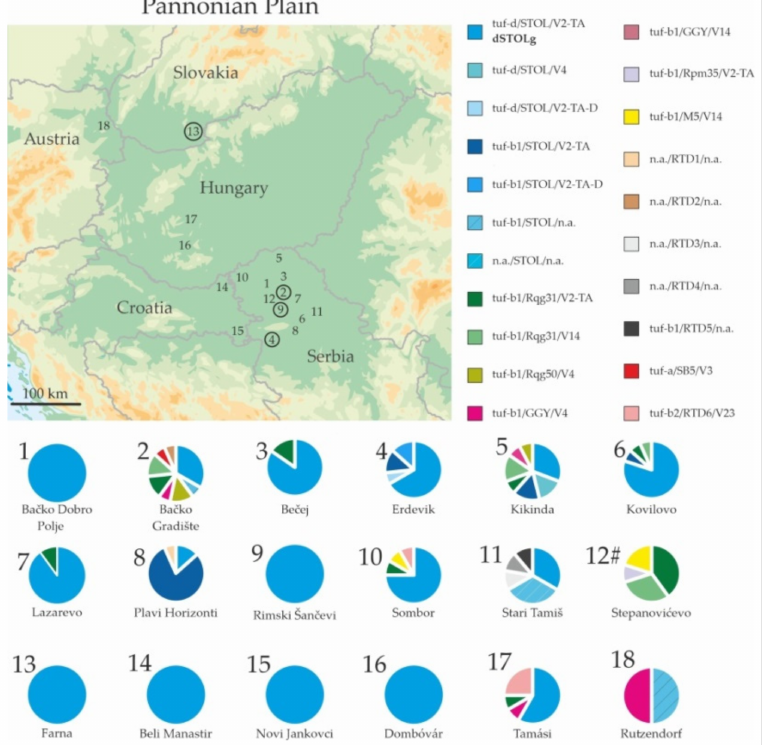
Figure 3. Map of the Pannonian Plain depicting sampling localities of the RTD-symptomatic sugar beets and red beets. Numbers on the map correspond to the collecting sites given in Table 1. Encircled numbers denote localities with epidemic RTD occurrence. Chart sections represent the proportion of the specific ‘ Ca . P. solani’ multilocus genotypes following the specified colour pattern given in the legend on the right. A total of 21 comprehensive genotypes detected in this study are presented by different colours. [11,12,38,47,50,51]. Unamplified genes within comprehensive genotypes are marked with the acronym